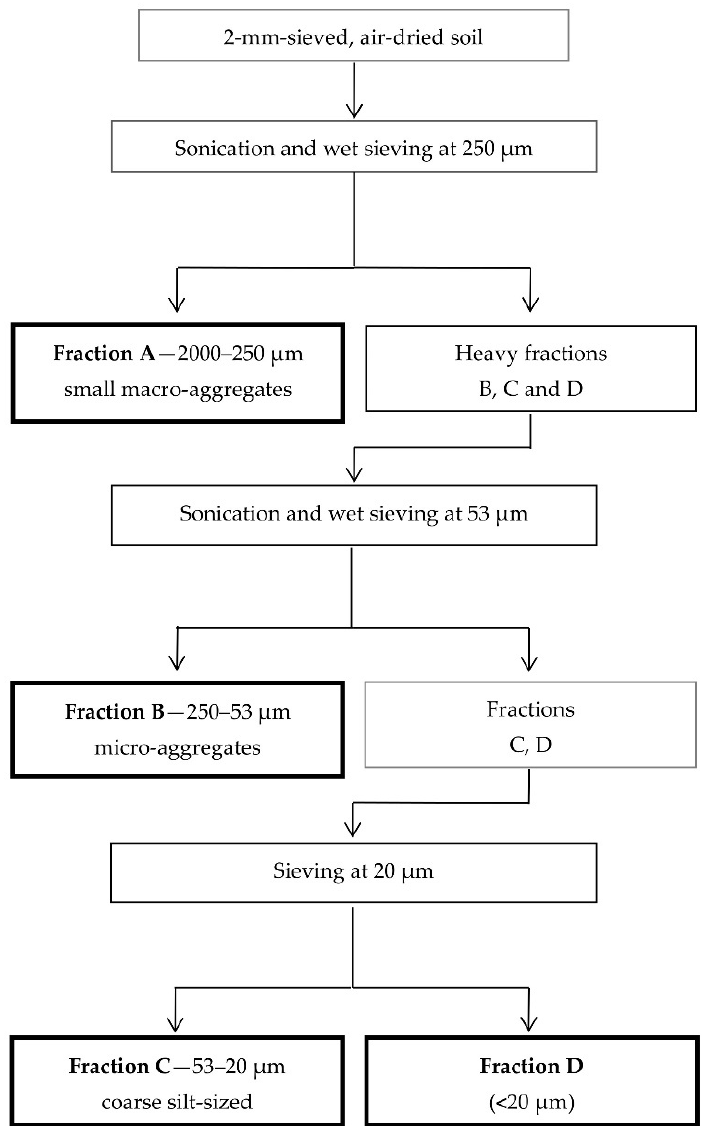
Figure 1. Fractionation scheme of soil.